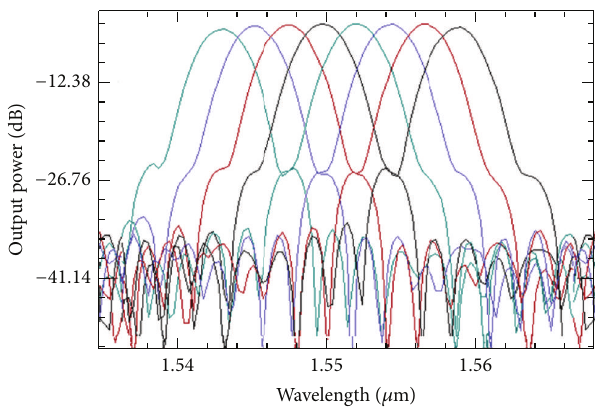
Figure 14: Transmission spectra simulation of a flat-top